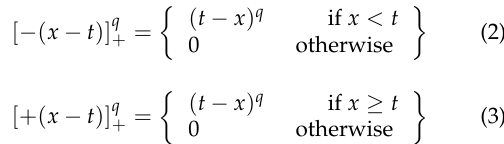
Fig. 2. Surface plots of settlement of pile versus input